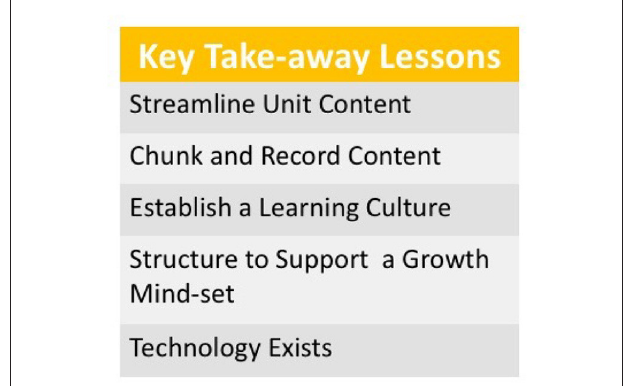
FIGURE 6 | Five core messages for others considering taking hydrology content online, based on the UWA